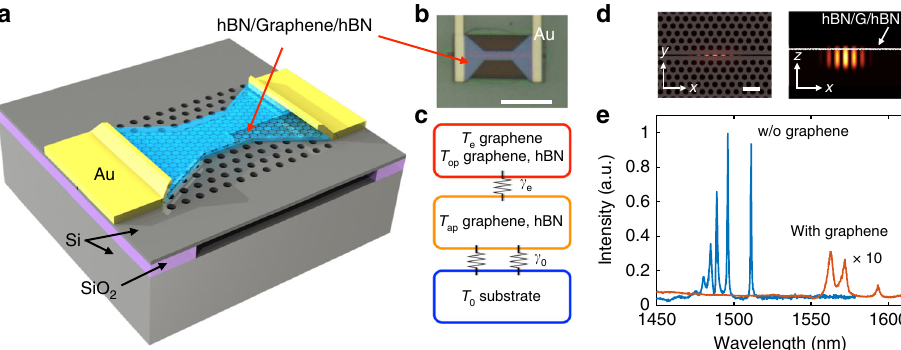
Fig. 1 Overview of the cavity-graphene thermal emitter. a Schematic of a cavity-integrated hBN/graphene/hBN light emitter with edge contacts. b Optical image of the fabricated device. Scale bar: 5 μ m . c Schematic of energy relaxation of graphene hot electrons. The red block corresponds to quasi-equilibrium of hot graphene electrons and optical phonons of graphene and hBN. Subsequently, the heat fl ows to the acoustic phonons and the substrate. d FDTD simulation of the electric fi eld pro fi le | E | 2 of the silicon PPC air-slot cavity indicates strongly con fi ned resonant modes. Scale bar: 1 μ m. e Re fl ection spectra of the PPC cavity before (blue) and after (red) deposition of graphene on the PPC surface